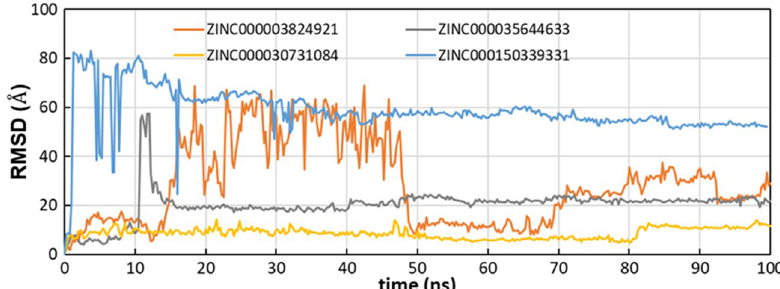
Figure 8. Time evolution of RMSD lig in the Omicron